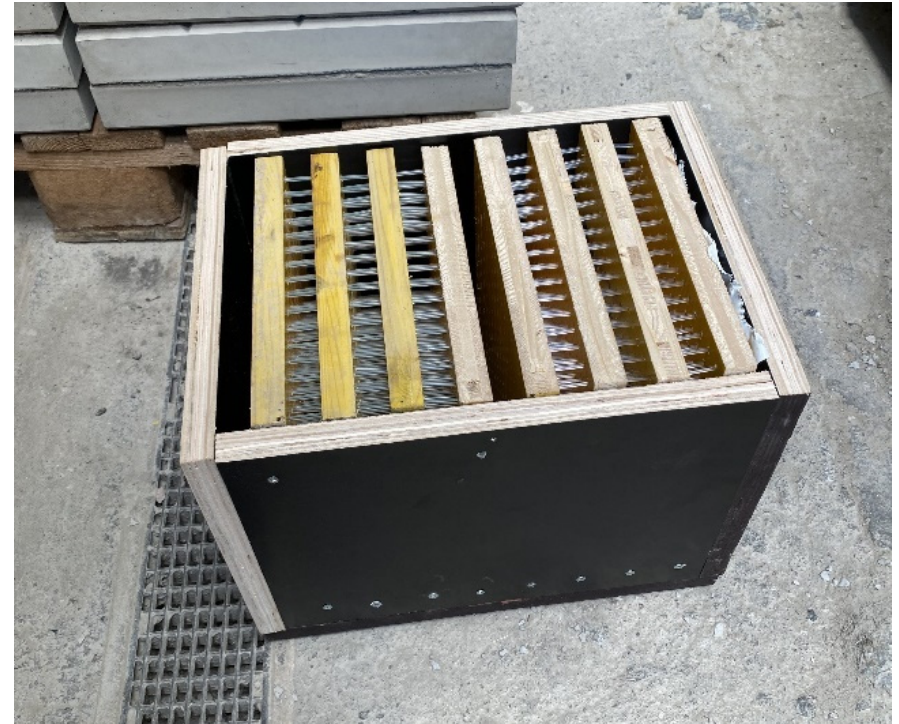
Figure 13. Formwork for making samples.